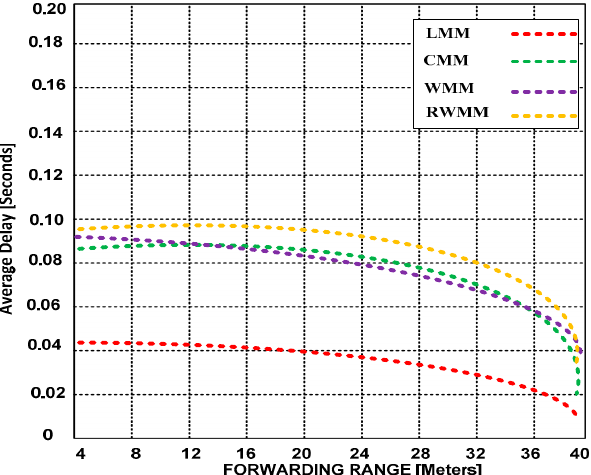
Figure 5. Average delay versus forwarding range at 50 m event range and 50% mobility.